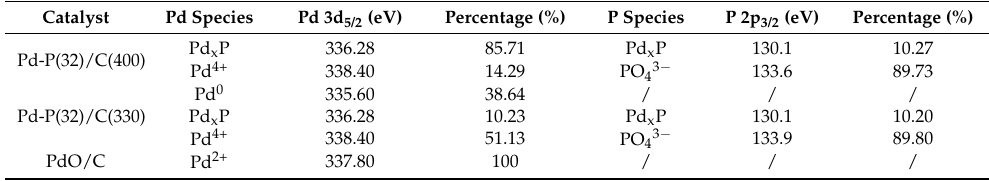
Figure 6. XPS spectra of P 2p for Pd-P(32)/C(330) and Pd-P(32)/C(400). Table 1. Relative content and binding energy of Pd and P species of PdO/C, Pd-P(32)/C(330), and Pd-P(32)/C(400).